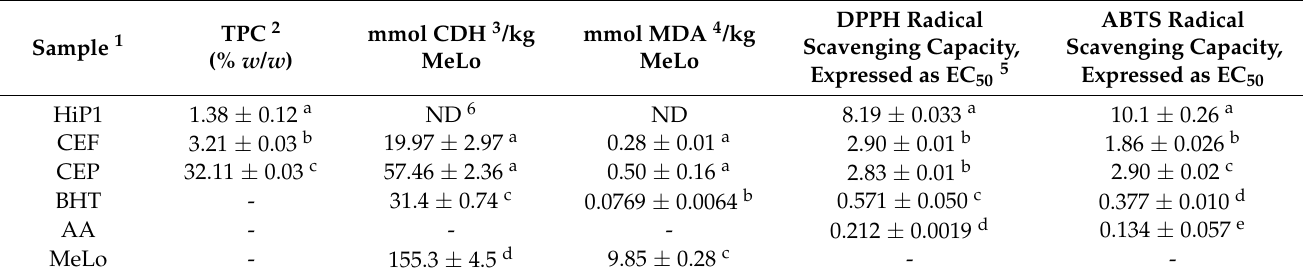
Table 4. In vitro antioxidant activity of extracts from S. filipendula